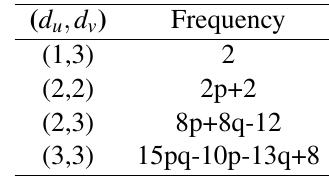
Table 1 Edge partition of Si 2 C 3 − III [ p , q ]